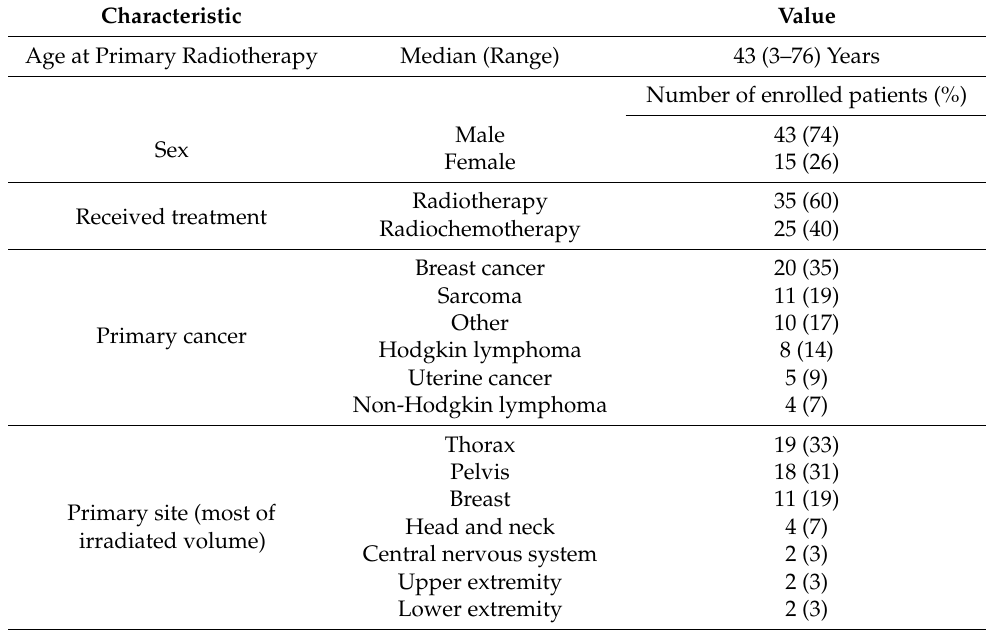
Table 1. Primary tumor characteristics.